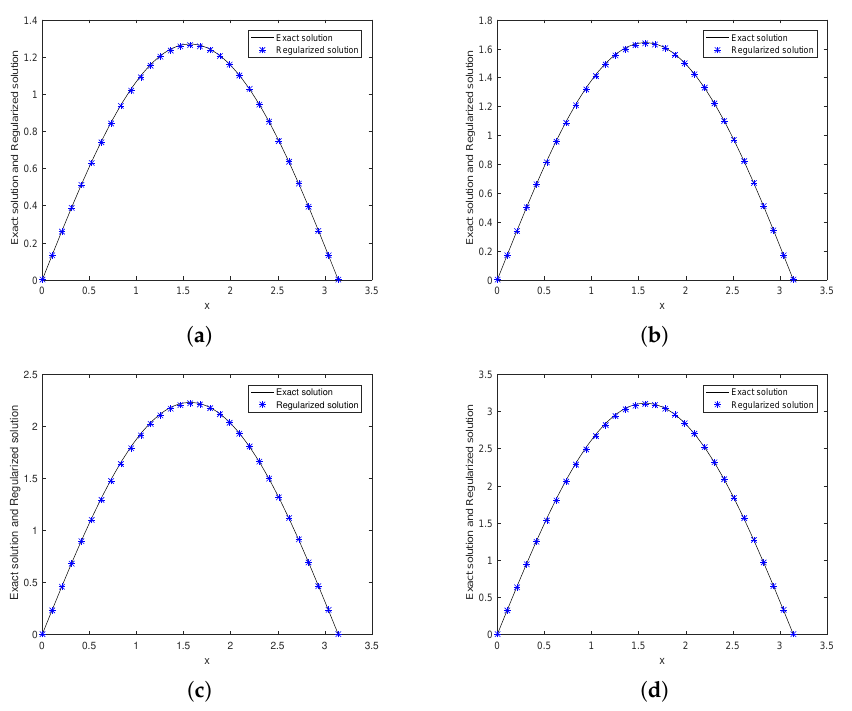
Figure 2. k = 1.5, ε = 0.01, γ = 2, the exact and regularized solutions; ( a ) y = 0.4, ( b ) y = 0.6, ( c ) y = 0.8, ( d ) y =